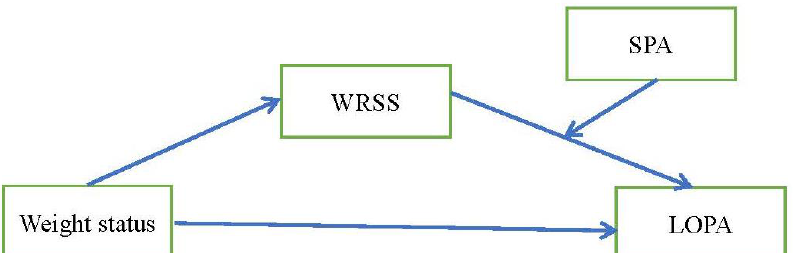
Figure 1. The hypothesized moderated meditation model to explain the moderator role of smartphone addiction (SPA) between the association of weight-related self-stigma (WRSS) and level of physical activity (LOPA), and the mediator role of WRSS between the association of weight status and LOPA in female college students.